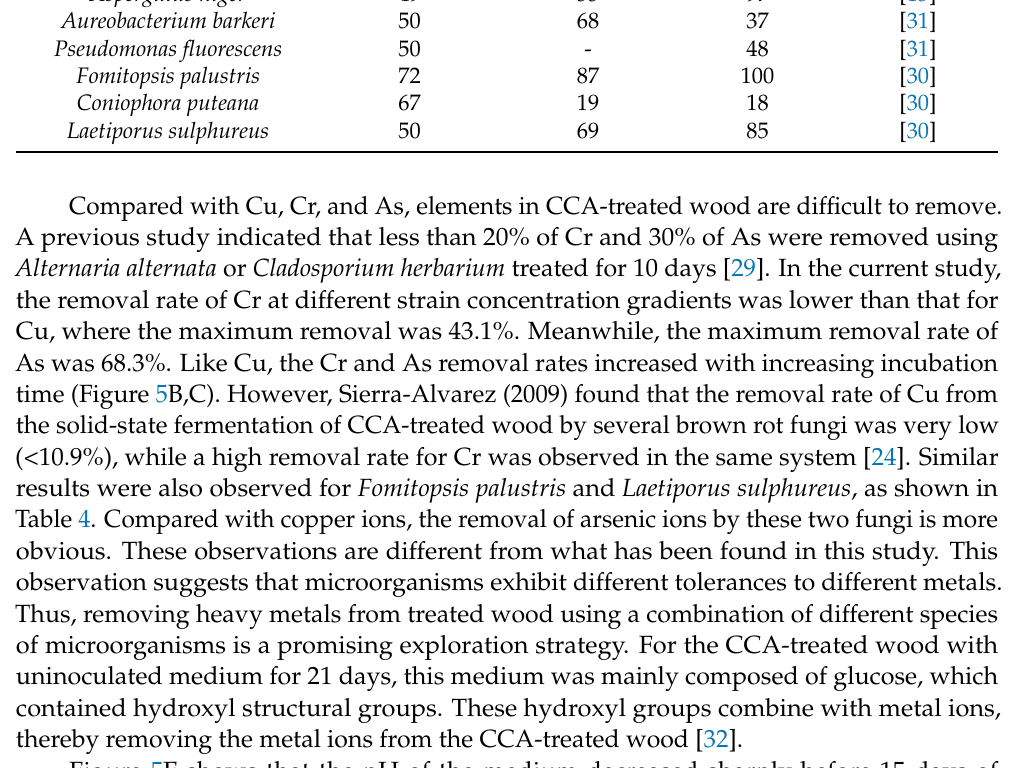
Table 4. Comparison of decontamination effects of different fungi on CCA wood. Maximum Metal Removal Rate (%) Microbes Cu Cr